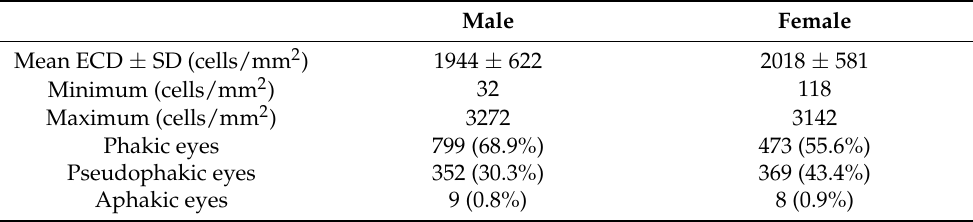
Table 4. Comparison of endothelial cell density (ECD) and lens status with respect to donor